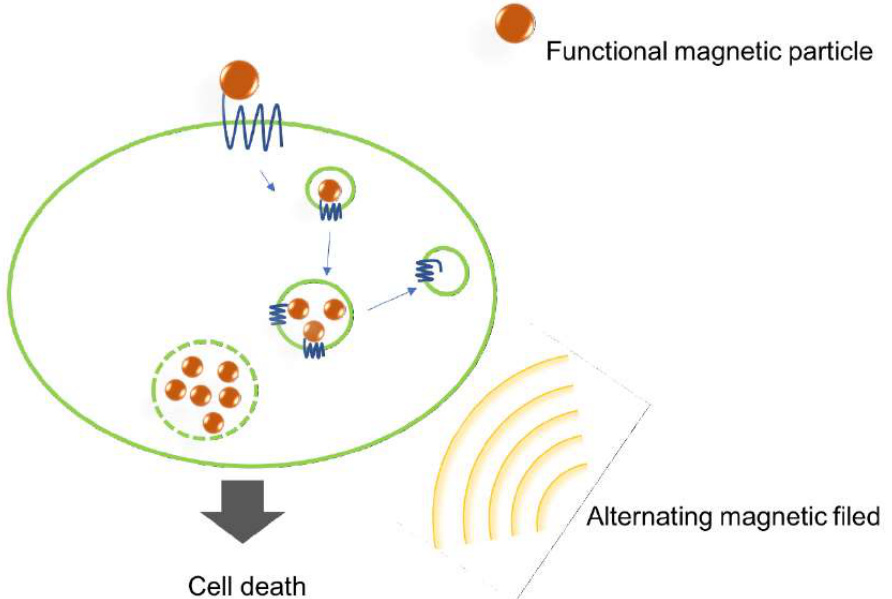
Figure 2. Mechanism of the cell death induced by magnetic particles. Functional magnetic nanoparticles (MNPs) recognize the surface receptor by ligand-receptor recognition. Upon binding to the receptor, MNPs are internalized and accumulated in lysosomes. When applying an external alternating magnetic field, lysosomal membranes break, which leads to cell death.